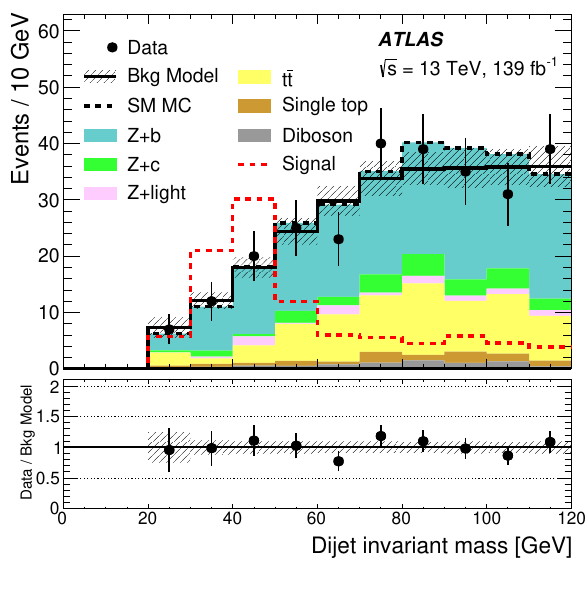
Figure 2. Distribution of the dijet invariant mass in the signal region, shown together with the parameterized background model (labelled ‘Bkg Model’). For reference, the MC prediction for the SM background is also shown (labelled ‘SM MC’). The Z+HF and tt scale factors, described in the text, have been applied to the simulated samples. The signal region is defined to have dijet invariant mass > 20 GeV. The total statistical and systematic uncertainties are denoted by the hatched band. The distribution labelled ‘Signal’ is for the model with ( m setting all branching ratios to 100% in the decay chain H → ˜ χ 0 tail on the signal distribution comes from selecting a jet that does not come from the a → b ¯ b decay. The lower panel shows the ratio of the observed data to the expectation from the parameterized background